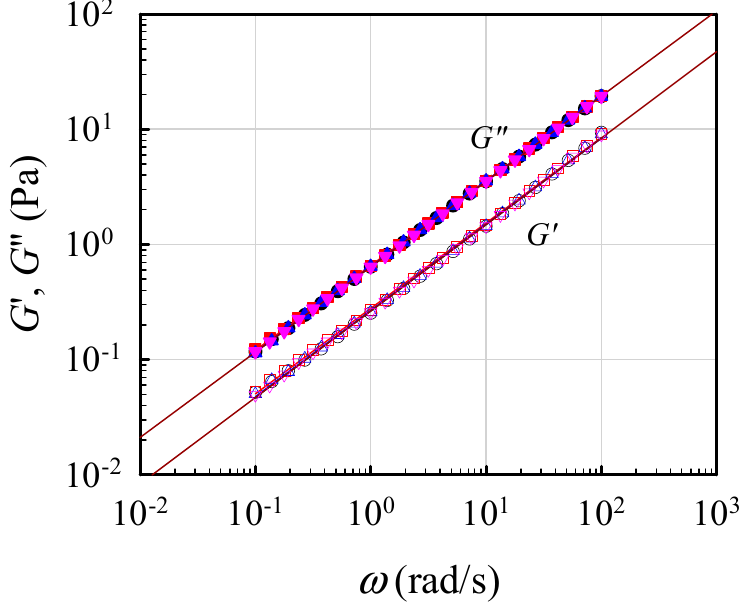
Figure 6. Parallel lines of log G’ and log G” vs. log ω to validate the formation of a critical gel at T gel for the 7 wt% solution, according to Equation (1).